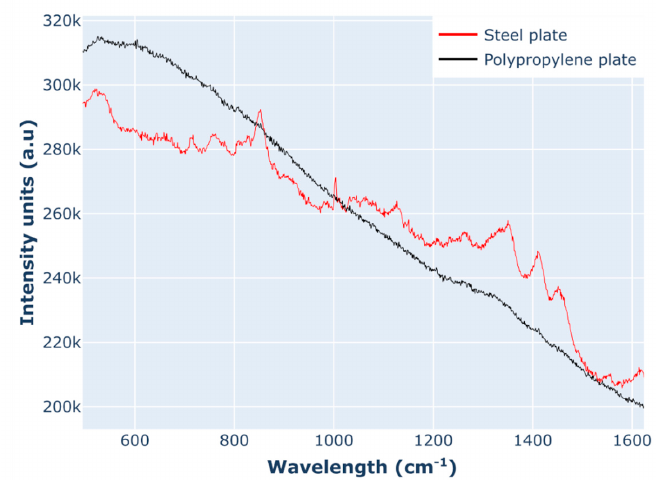
Figure 9. Comparison of acquisition settings of the spectra recorded by HT Raman spectroscopy microscope using polypropylene plates (in black) compared to the improved acquisition settings using stainless steel (SS) plates, a higher laser power, and higher magnification objective (in